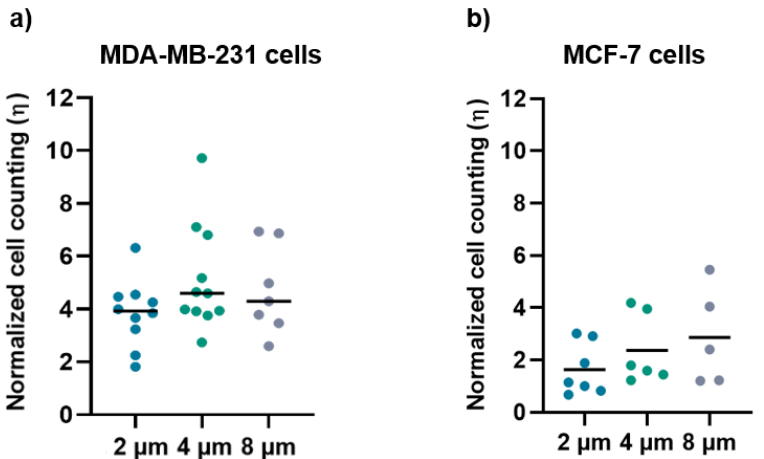
Figure 7. ( a ) Normalized cell counting values for the MDA-MB-231 cells on 2 µ m (n = 10), 4 µ m (n = 11), and 8 µ m (n = 7) wide micro-gaps; ( b ) normalized cell-counting values for the MCF-7 cells on 2 µ m (n = 7), 4 µ m (n = 6), and 8 µ m (n = 5) wide micro-gaps. The black line is the mean value for each data set.